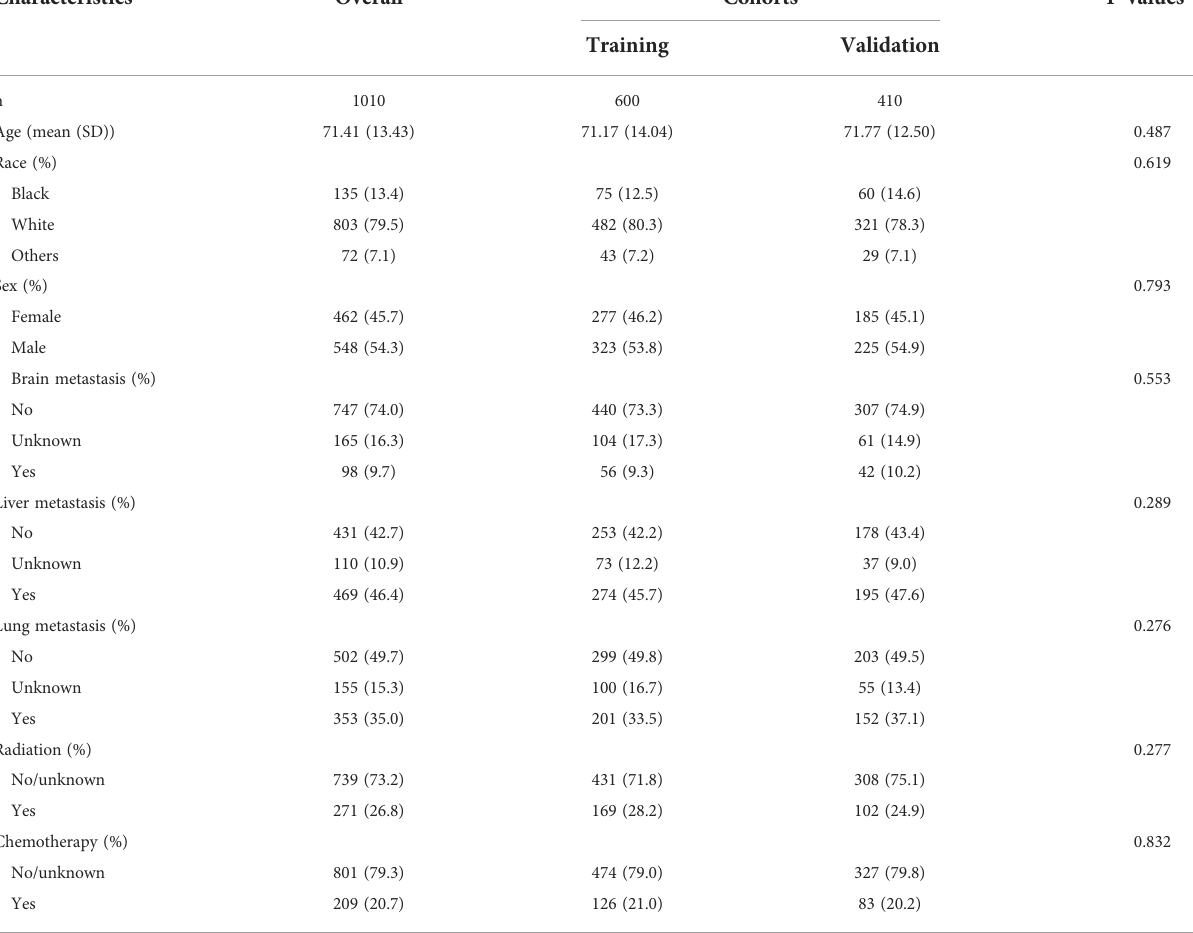
TABLE 1 Patient ’ s demographics and clinical